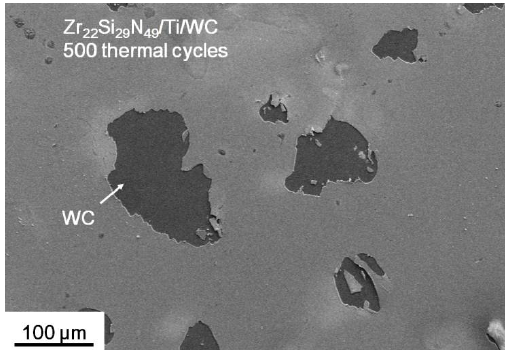
Figure 11. Surface morphology of the contact area of the Zr 22 Si 29 N 49 /Ti/WC assembly after 500 thermal cycles.